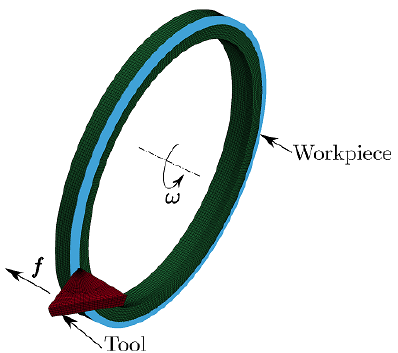
Figure 3. A coupled SPH-FE model of three-dimensional turning operation: Blue colour region of the workpiece is meshed using SPH particles, whereas green coloured region is meshed with FE mesh.